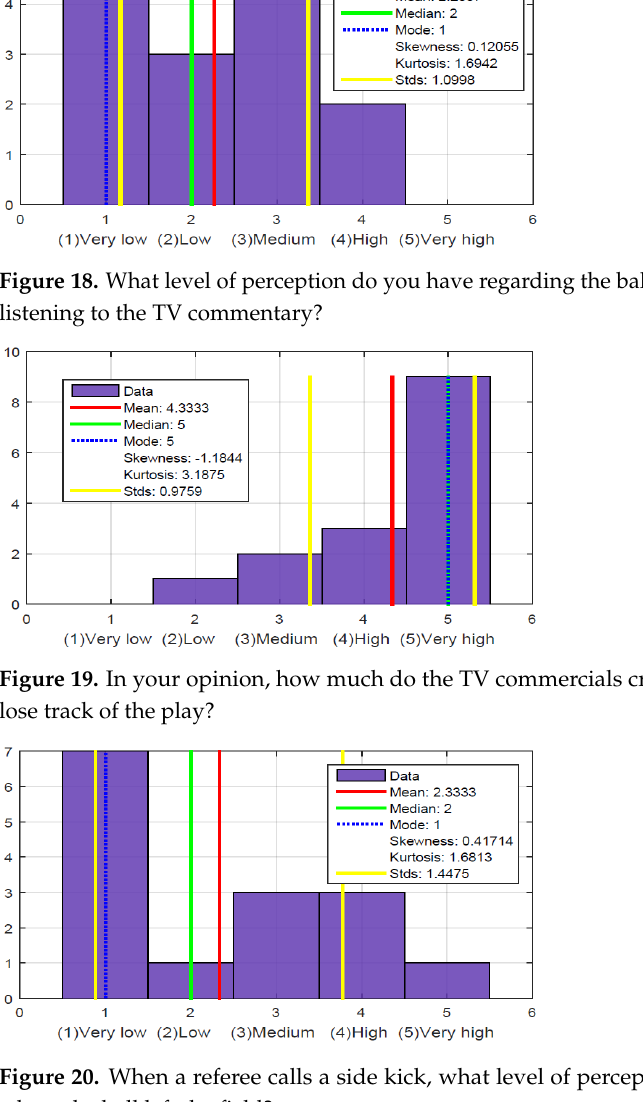
Figure 20. When a referee calls a side kick, what level of perception do you have about the place where the ball left the